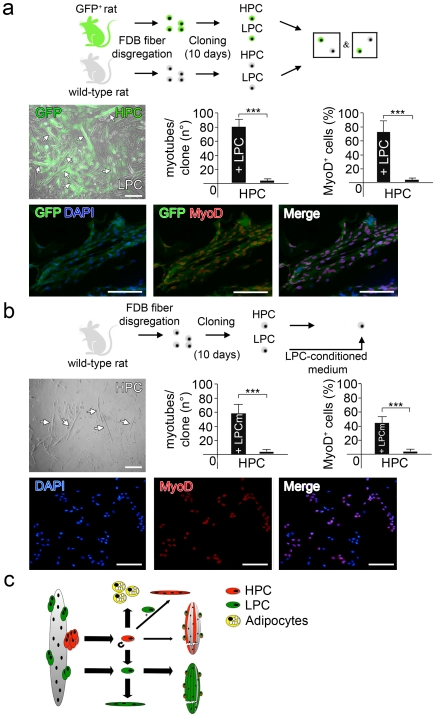
Co-culture of LPC and HPC.(a) Scheme for co-cultures: SCs were derived from FDB muscles of both wild-type and GFP+ rats then cloned through limiting dilutions and after 10 days of culture HPC were seeded on LPC (top panel). Increase in myotube formation derived from HPC. Epifluorescence for GFP+ myotubes (indicated with white arrows, central panel left, bar = 100 µm), and diagrams indicating number of myotubes per clone (central panel, center) and percentage of MyoD+ cells (central panel, right) in co-cultures, compared to control HPC (mean values±s.d., ***p<0.001). Immunostaining for MyoD and epifluorescence for GFP, merged with DAPI on co-cultures (bottom panel, bar = 100 µm). (b) Scheme for culture in conditioned medium: SCs were derived from FDB muscles of wild-type rats then cloned through limiting dilutions. After 10 days of culture LPC-conditioned medium was transferred on HPC (top panel). Myotube formation (indicated with white arrows, central panel left, bar = 100 µm), and diagrams indicating number of myotubes per clone (center) and percentage of MyoD+ cells (right) in cultures with LPC-conditioned medium, compared to control HPC (mean values±s.d., ***p<0.001; middle panel). Immunostaining for MyoD on HPC cells, subjected to LPC-conditioned medium, merged with DAPI (bottom panel, bar = 100 µm). (c) Cartoon of the current working model: pools of Satellite Cells can be isolated from the muscle fiber and cultured in vitro preserving their original diversities. HPC spontaneously differentiate into adipocytes whilst LPC into myoblasts. Notably, HPC may undergo myogenic pathway if cultured together with LPC. LPC and HPC in vitro diversities mirror differences in the capacity of regenerating damaged muscles tissues.